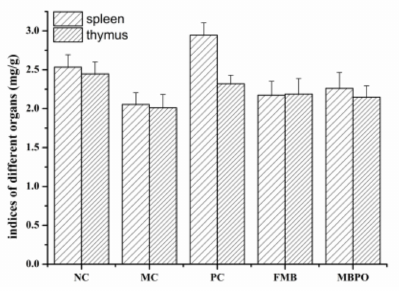
Figure 6. Index of spleen and thymus organs in mice.